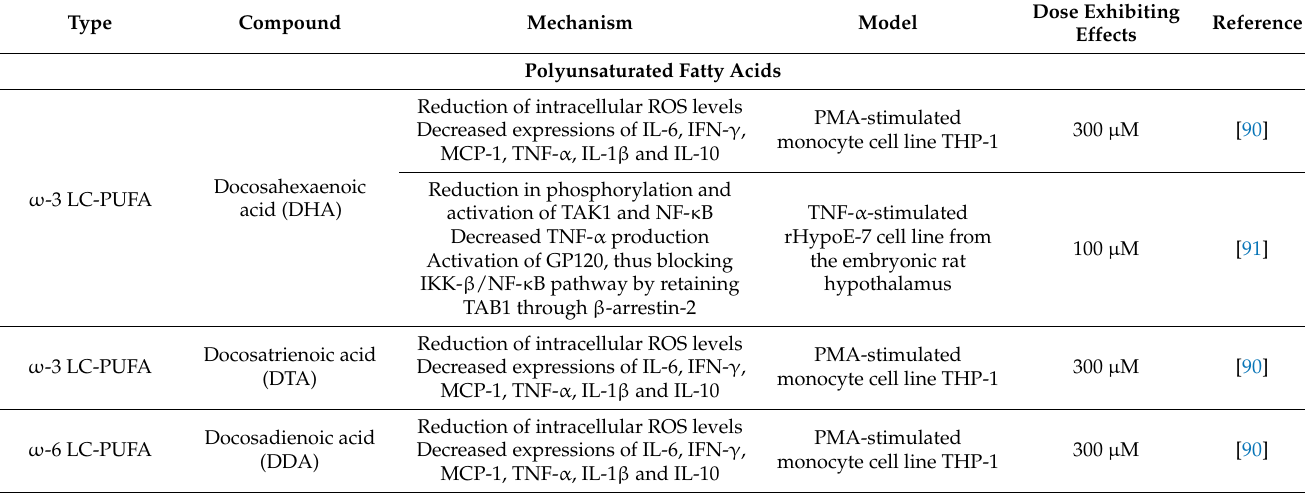
Figure 5. ( A ) Chemical structure of the main terpenes and terpenoids present in anti-inflammatory diets. ( B ) Anti- inflammatory mechanisms in which terpenes and terpenoids are involved. Thin arrows and bar-headed lines mean activation and inhibition of the pathway respectively. Thick arrows mean translocation. Table 2. Outline of the forementioned anti-inflammatory compounds, their molecular mechanisms, and dose exhibition